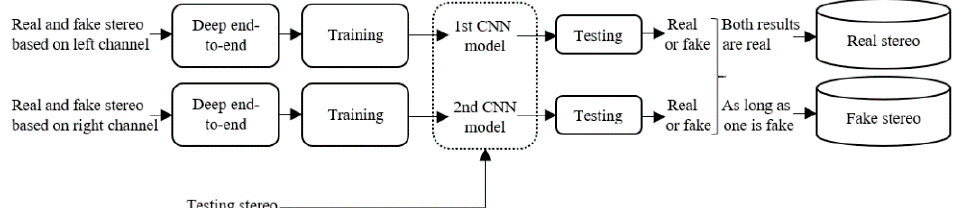
Figure 7. Deep end-to-end algorithm flowchart. In the training stage, the dataset for training is composed of a real stereo set and two fake stereo sets (1st CNN classifier and 2nd CNN classifier).